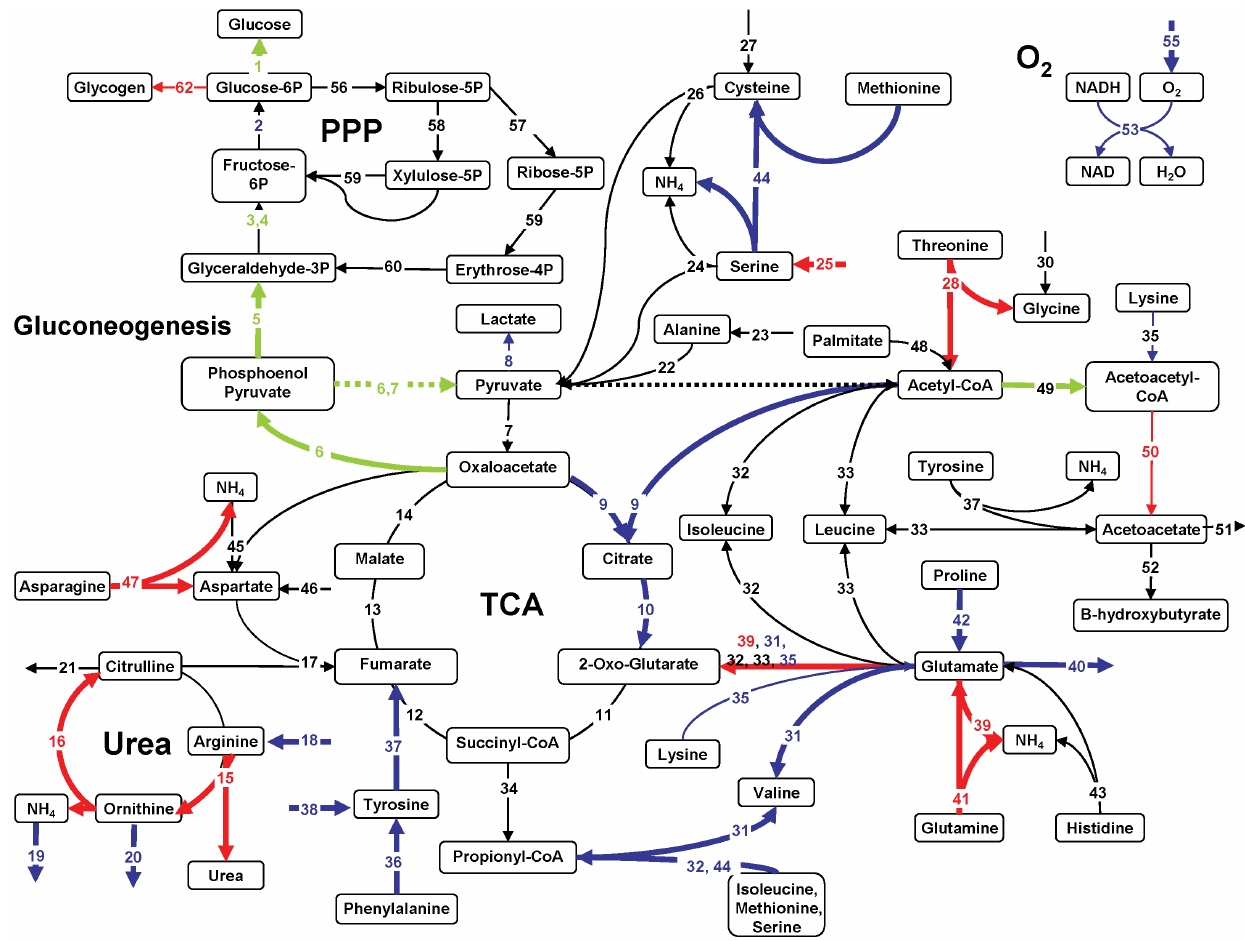
Figure 5. MFA of phase II (t=3–5 hrs) for WI livers compared to Fresh livers; Fresh liver MFA forms the black baseline. Red arrows are significantly increased fluxes. Blue arrows are significantly reduced fluxes and green are reversed. Bold lines=p , 0.05, Thin lines=p , 0.1, Dotted lines=glycolysis.